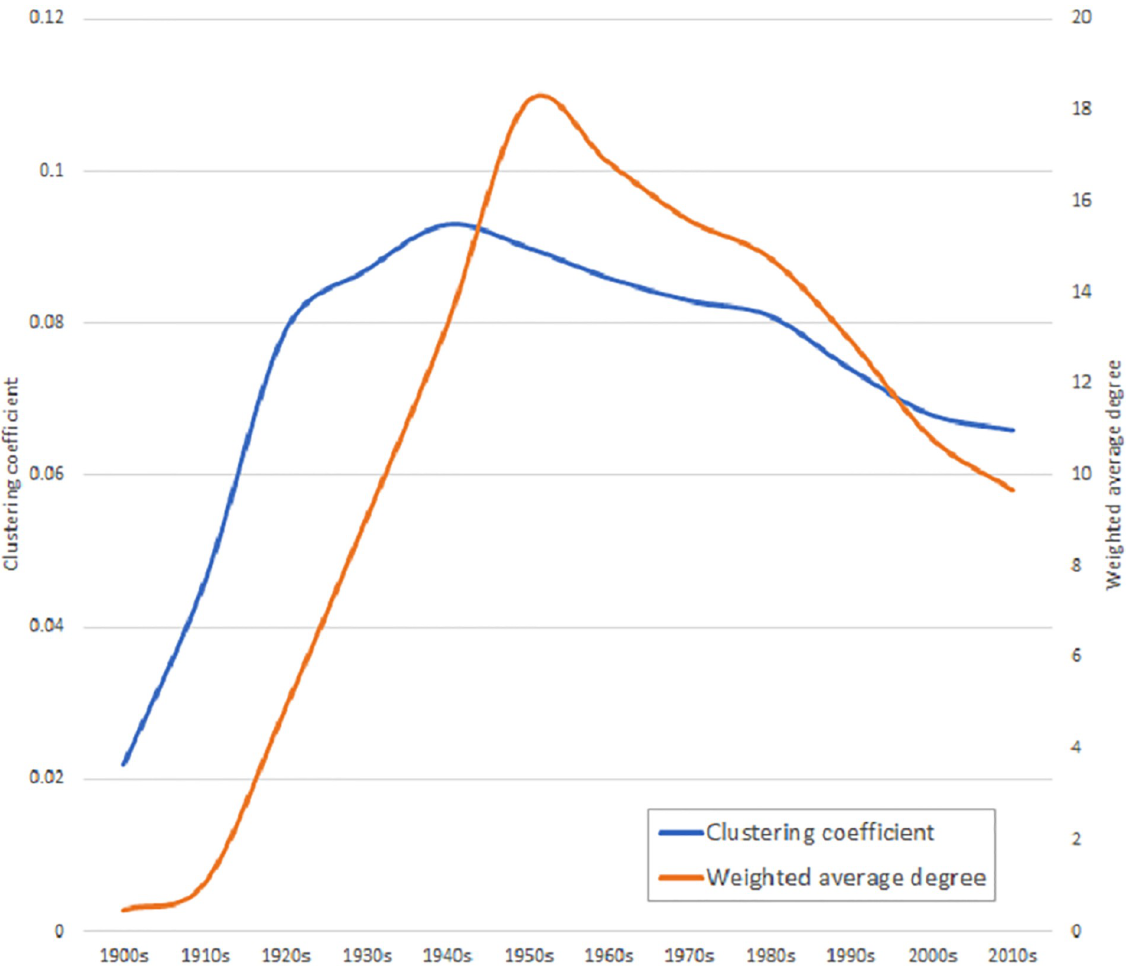
Fig 2. Evolution of the weighted average degree and clustering coefficient over the